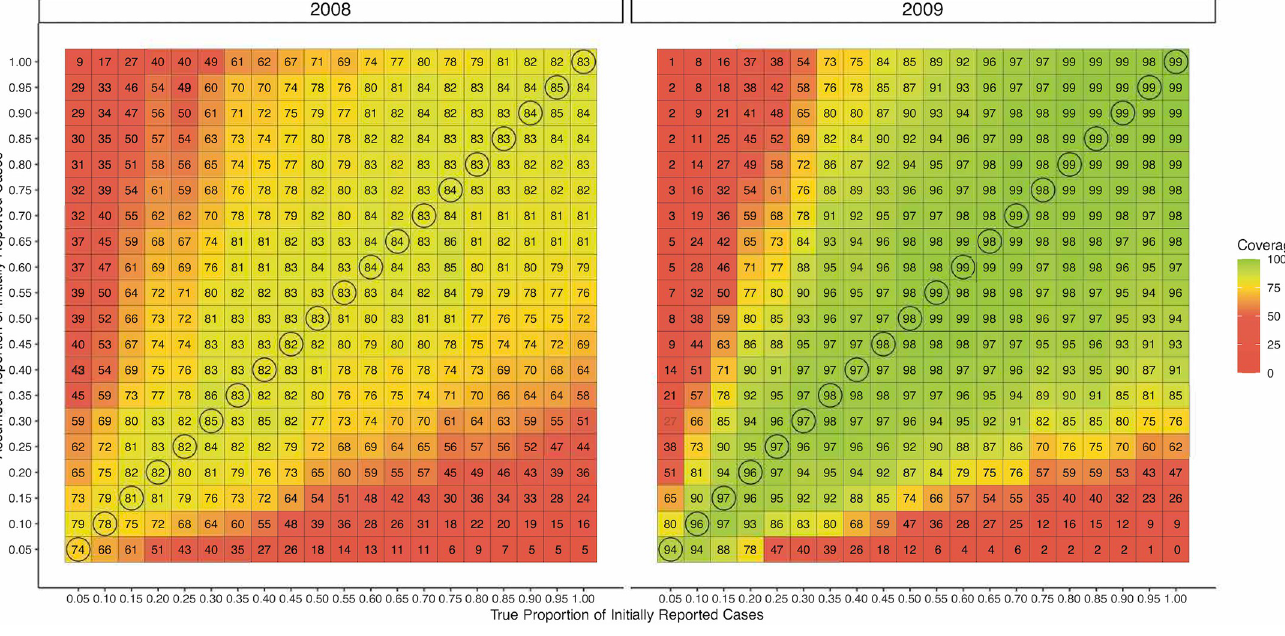
Fig 6. Coverage of 95% prediction intervals for 1 week forecasts across various assumed reporting profiles in 2008 and 2009 simulated datasets 1 . 1 Circled coverages correspond to correctly-specified reporting factors.